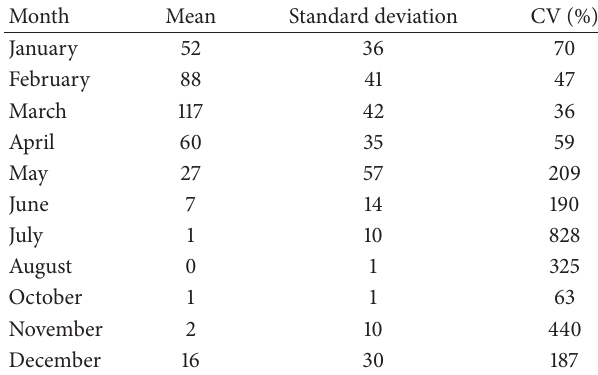
Table 2: Monthly mean (mm), standard deviation (mm), and the coefficient of variation (CV) of the mean rainfall from the five stations (see Figure 1) in NW